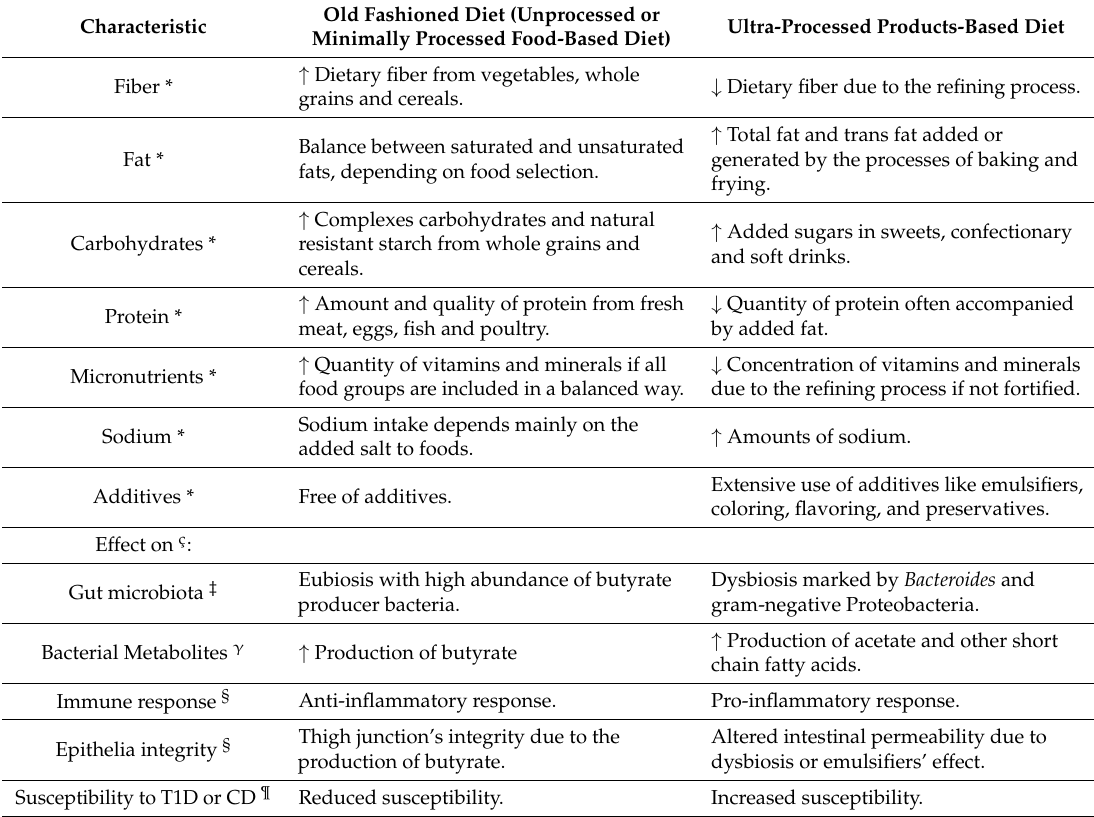
Table 2. Comparative characteristics of compounds and overall effects of old fashioned diet vs. ultra-processed food-based